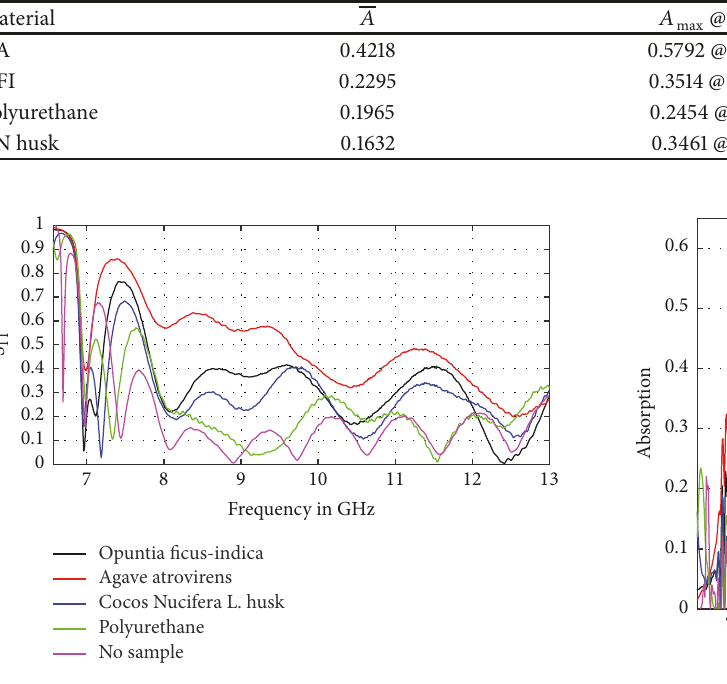
Figure 4: S 11 for the waveguide considering samples of organic materials, polyurethane, and no sample.